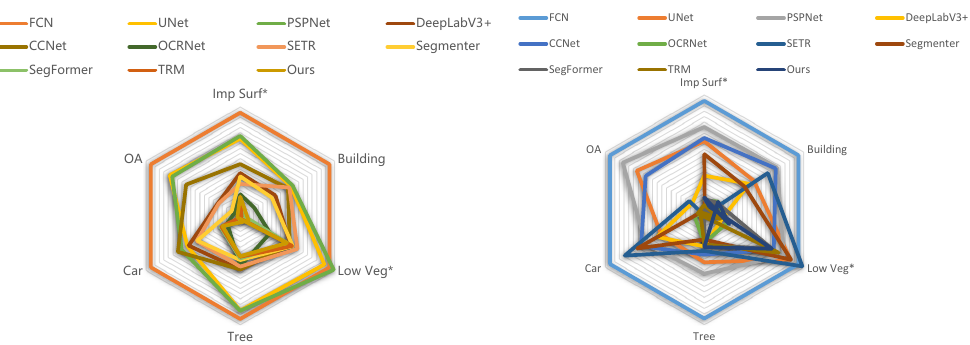
Figure 12. Radar plot for the robust performance of several SOTAs on the Potsdam test set. The enve- lope area of a robust model should be small and balanced. Although ViTs can boost the performance, CNNs manifest stronger robustness compared with